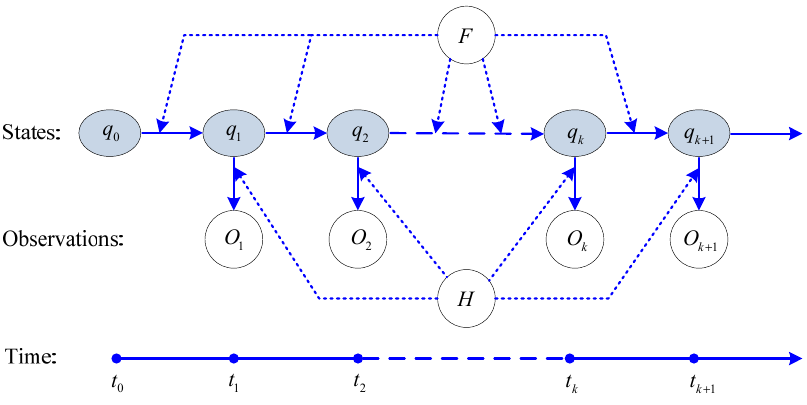
Figure 3. Topology structure of the hidden Markov